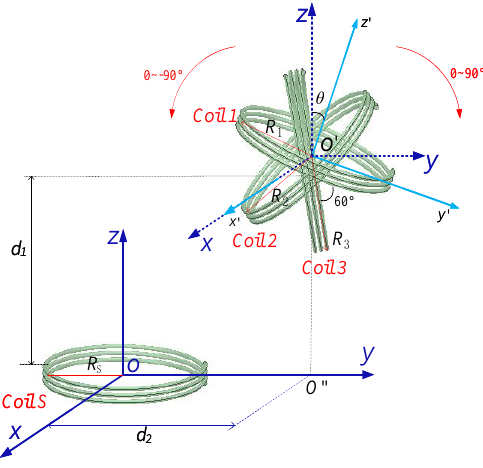
Figure 1. The diagrammatic sketch of the proposed structure.